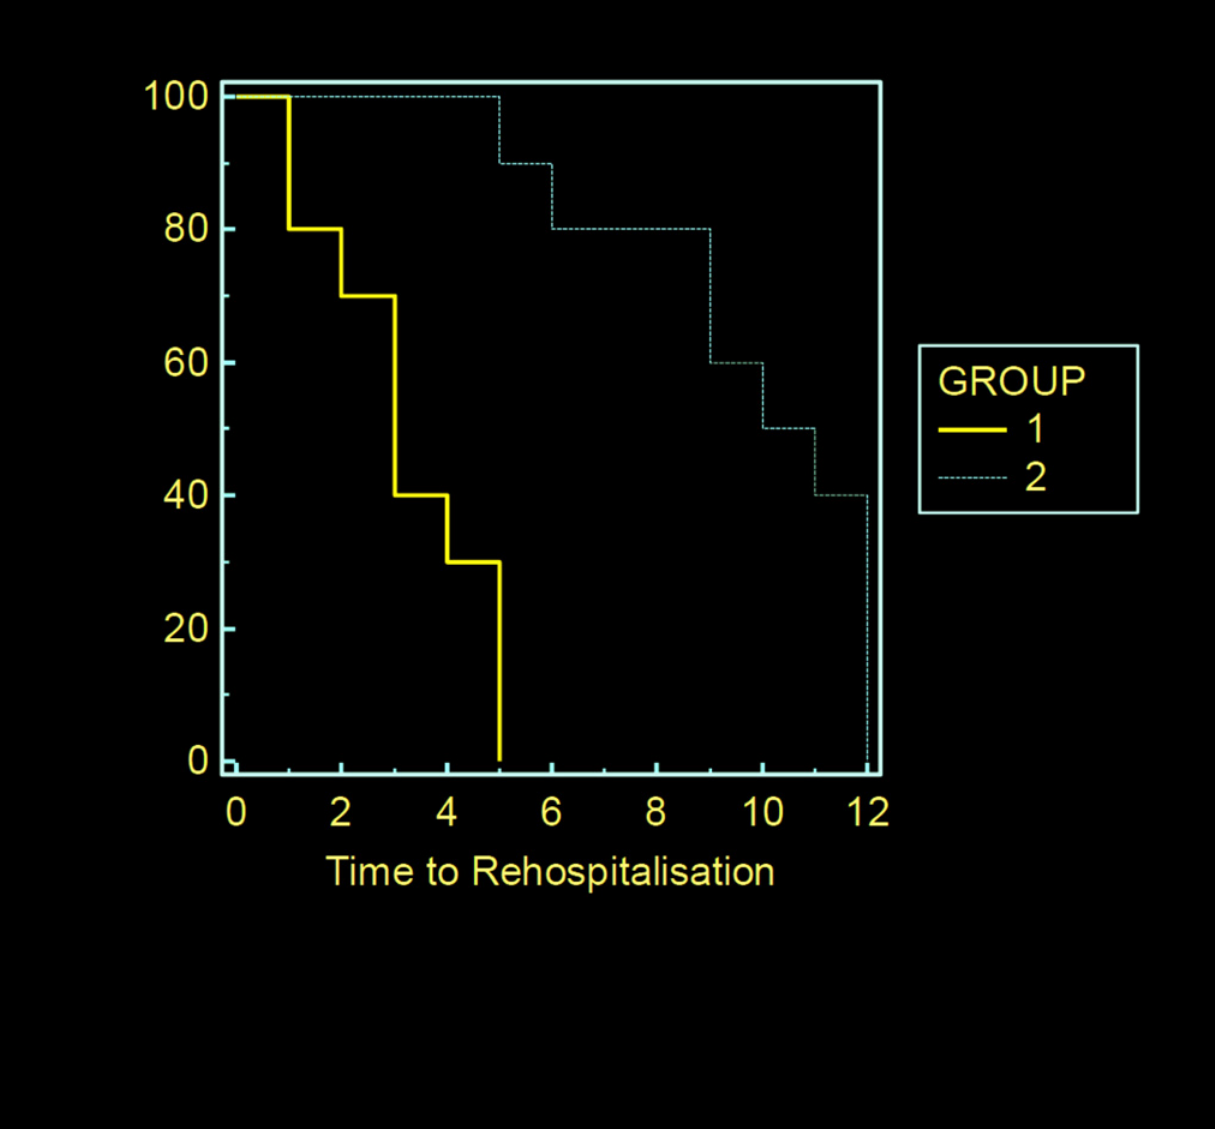
Fig 2. Comparism of the rate of re- hospitalization between subjects with right ventricular systolic function and those with right ventricular systolic dysfunction. Group 1- Subjects with tricuspid annular plane excursion (TAPSE) less than 15mm. Group 2- Subjects with tricuspid annular plane excursion (TAPSE) greater than or equal to